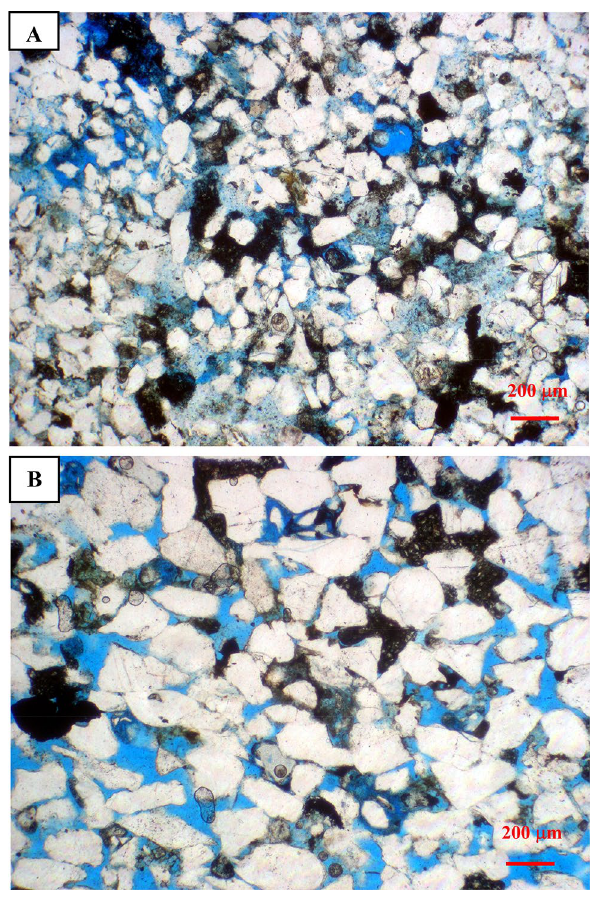
Fig. 7 Photomicrograph (PPL) of high-porosity quartz arenite. a S#8 represents group (A), K = 149 mD & ϕ = 27.9%. b S#3 represents group (B), K = 3578 mD & ϕ = 29.3%